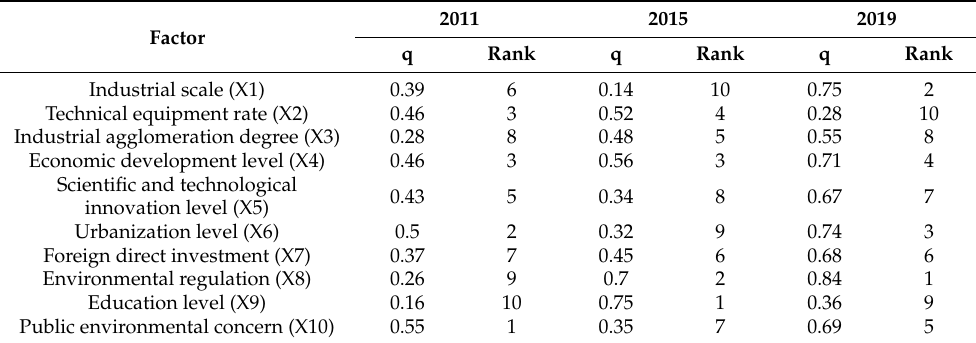
Table 5. Factor detection results of space-time differentiation of green technology innovation efficiency in the Chengdu–Chongqing urban